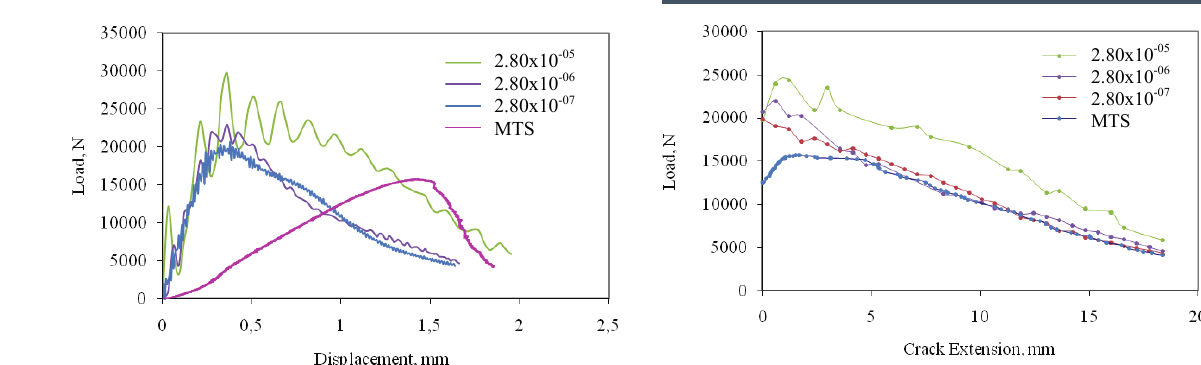
Figure 10: The load-crack extension response at different mass density and the comparison with the experimental data. 4.3 Sensitivity of Maximum Strength The maximum strength is denoted by the strength of two adjacent cohesive elements of the specimen. It is needed to overcome the maximum strength to propagate the crack. To evaluate the material response, three different sets (800MPa, 700MPa, 600MPa) of data were used. Figures 11 and 12 show Figure 11: The load-displacement values at the different maximum strength of the cohesive element and the comparison with the the load-displacement and the load-crack extension response respectively in Arcan specimen in mode-I.. In that case, other experimental data. parameters were constant. The maximum displacement jump was used as 0.12, the loading velocity 0.6x10 +02 mm/sec, whereas in the experimental case the loading velocity was 0.6x10 -03 mm/sec. Thus in the simulation, the loading velocity was increased by 10 times. The mass density was used as 2.80x10 -05 ton/mm 3 , whereas the original value of the mass density was 2.80x10 -09 ton/mm The mass density increased by 10 4 times in the simulation. The crack length of 16.58 mm was observed.